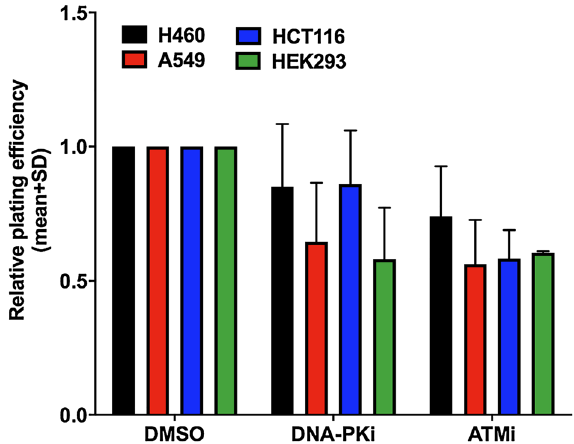
Figure 1. Reduction of plating efficiency after DDR inhibitor treatment in various cancer cells.